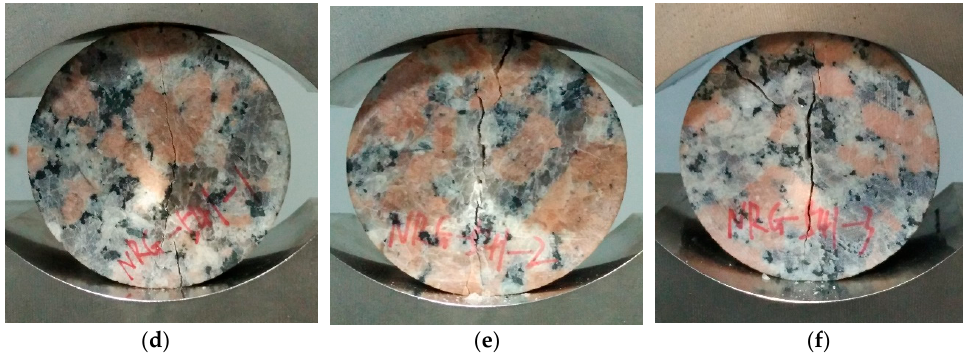
Figure 5. The failure characteristics of the rock specimens under both UCS and UTS testing.